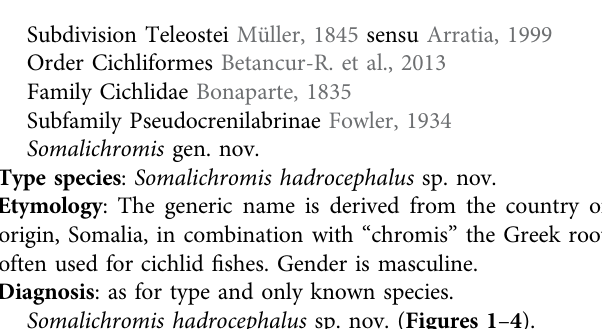
Frontiers in Earth Science |